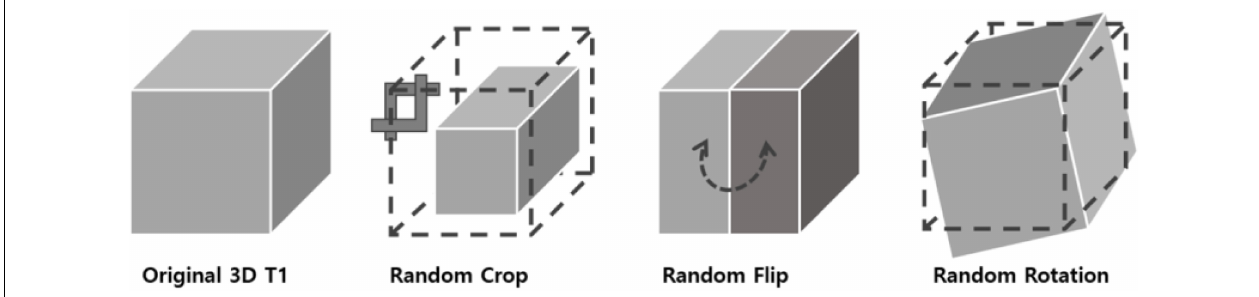
FIGURE 2 | 3D data transformations used for data augmentation. Three types of geometrical transformations were applied to the 3D MRI data augment the data set: cropping of the image, left-right flips, and in-plane rotations.